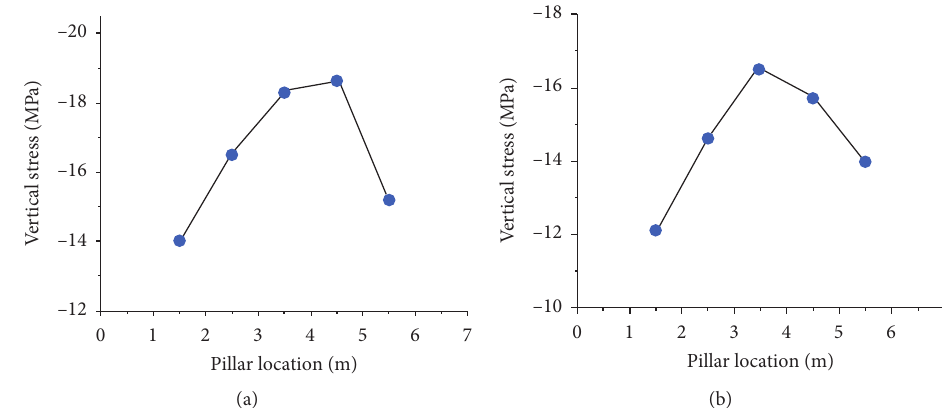
Figure 20: The stress distribution in the coal pillar after using the proposed technologies. (a) Location: +80m. (b) Location: +150